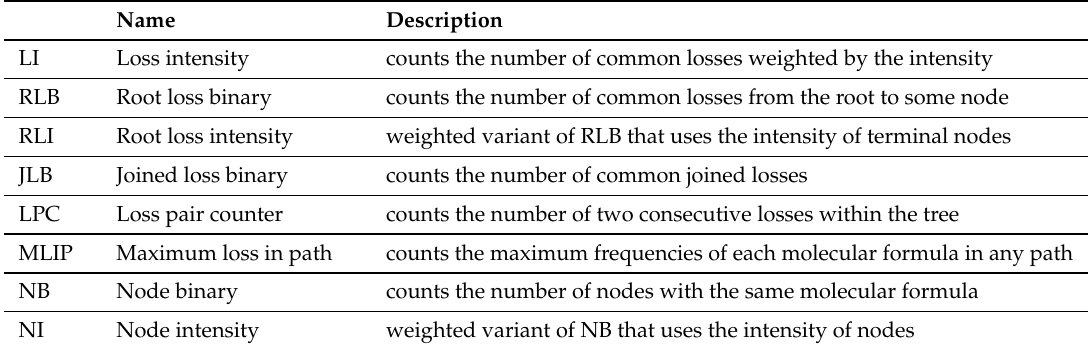
Table 1. Description of the input kernels (see [34] for further